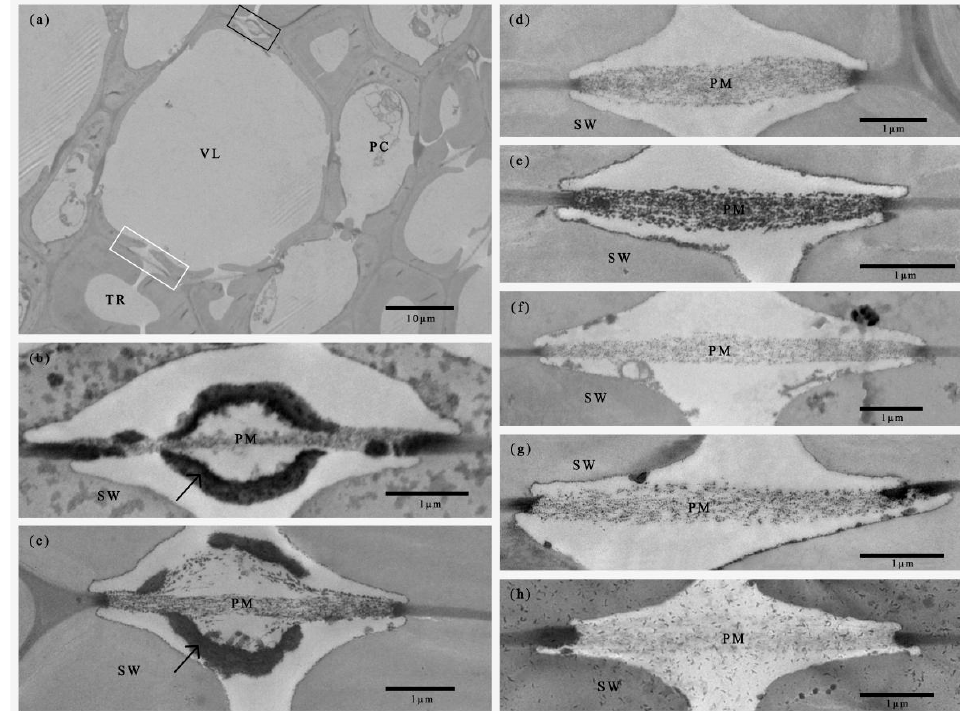
Figure 3. Transmission electron microscope images of stem xylem of Misty ( a , e ), O’Neal ( b , d ), Tifblue ( c , f ), Britewell ( g ), and Climax ( h ). Both homogenous pit membrane ( a , d – h ) and pseudo-tori pit membrane ( a – c ) are shown in cross-sections of stem xylem. The white and black box shows the homogenous pit membrane and the pseudo-torus pit membrane, respectively. The black arrow points to the pseudo-torus arching over the pit membrane. VL = vessel lumen, TR = tracheid, PC = parenchyma cell, SW = secondary wall, PM = pit membrane.